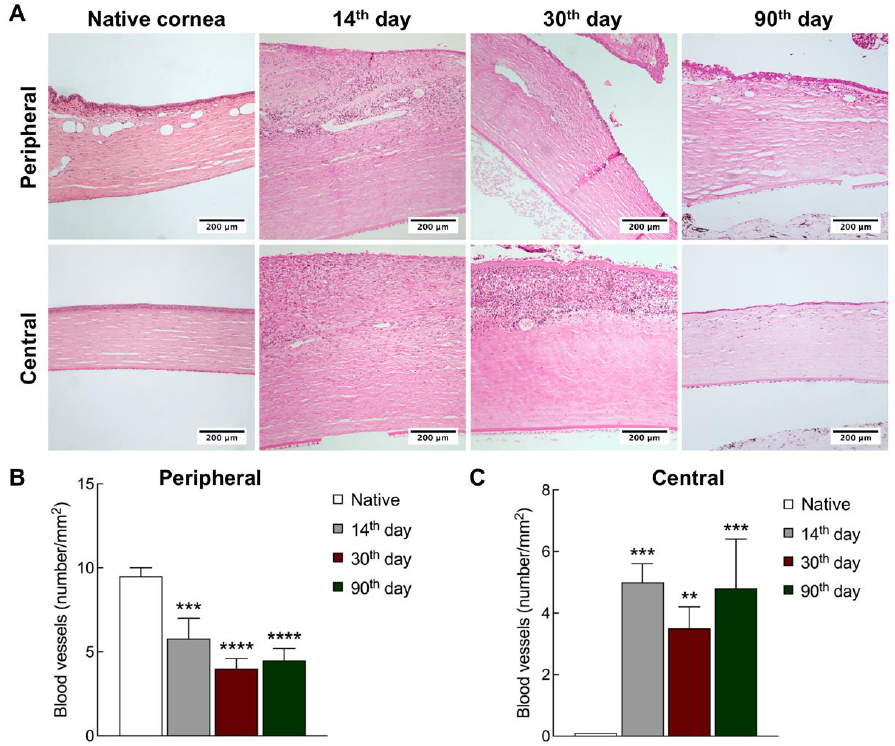
Figure 3. Corneal regeneration dynamics after transplantation of L-MSCs-EGFP onto the decellu- larized amniotic membrane. ( A ) Peripheral and central rabbit cornea at different time points after L-MSCs-EGFP transplantation. Hematoxylin-eosin staining. Scale bars: 200 µ m. ( B , C ) The changes in the number of blood vessels in the peripheral and central stroma at different time points after transplantation (n = 3; ** p < 0.001, *** p < 0.0002, **** p < 0.0001). 2.4. L-MSCs-EGFP Localization in Corneal Tissue after Transplantation The distribution and viability of green fluorescent protein-labeled cells in the corneal tissue were evaluated at different time points after the transplantation to rabbits.